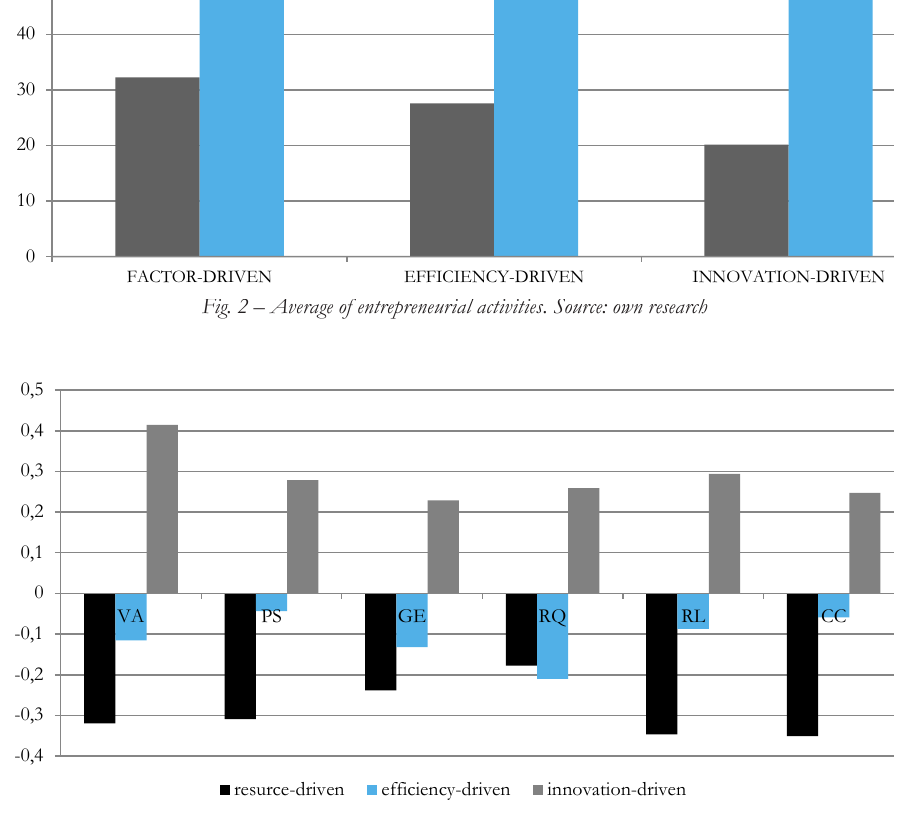
Fig. 3 – Average of governance quality indicator. Source: own research